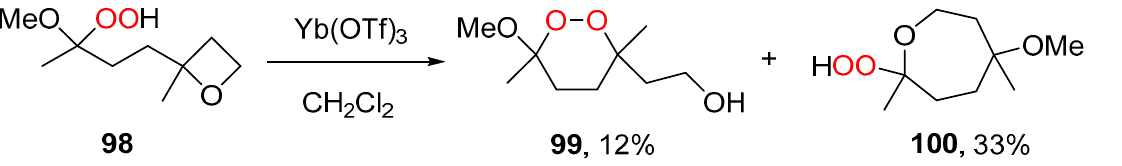
Scheme 34. Synthesis of hydroperoxides 96 from oxetanes 95